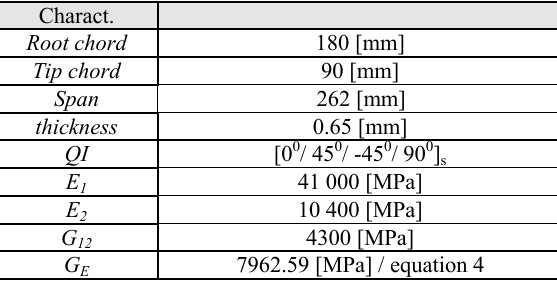
Table 3. Samples Geometric and material data Charact.